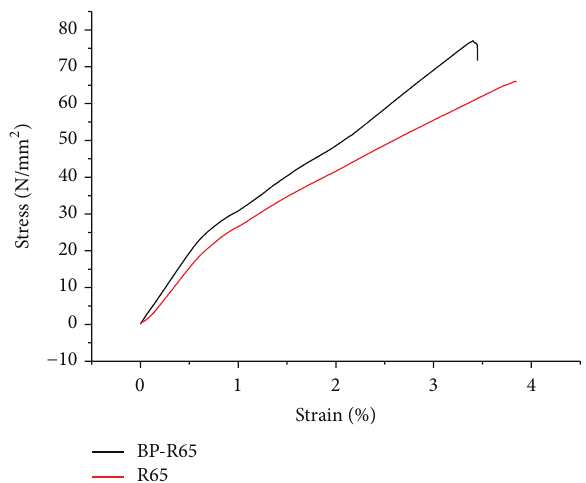
Figure 7: The average values for tensile and flexural strength values of R-65 and BP-R65 test